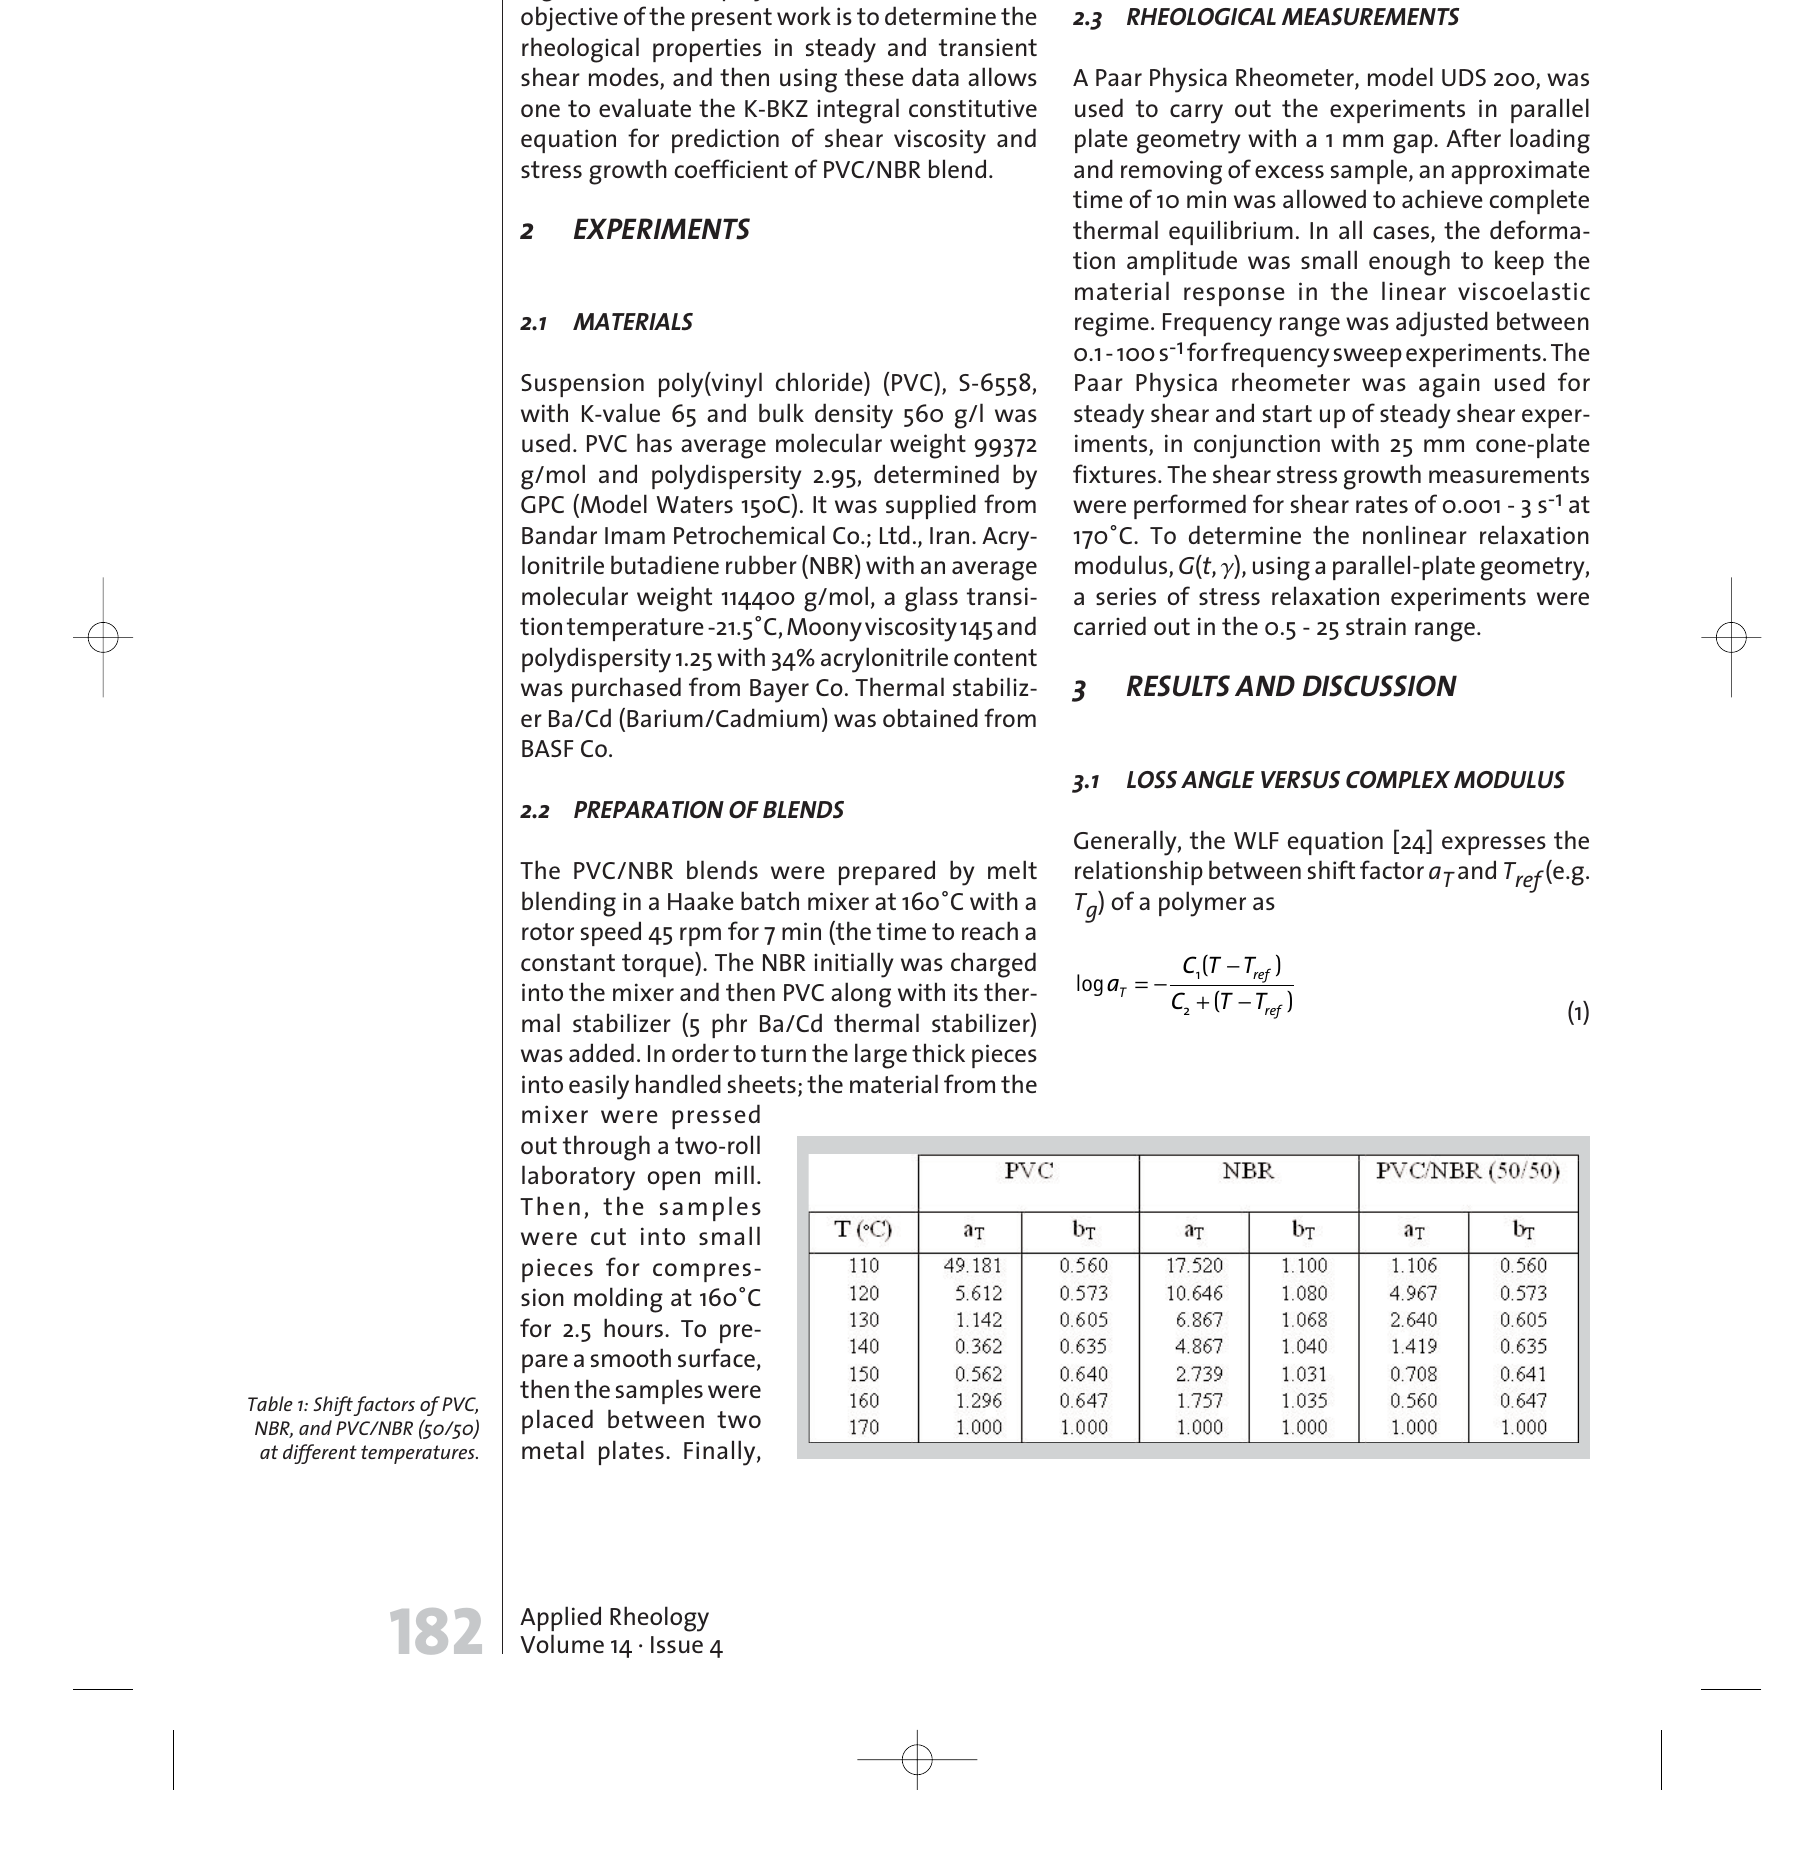
Table 1: Shift factors of PVC, NBR, and PVC/NBR (50/50) at different